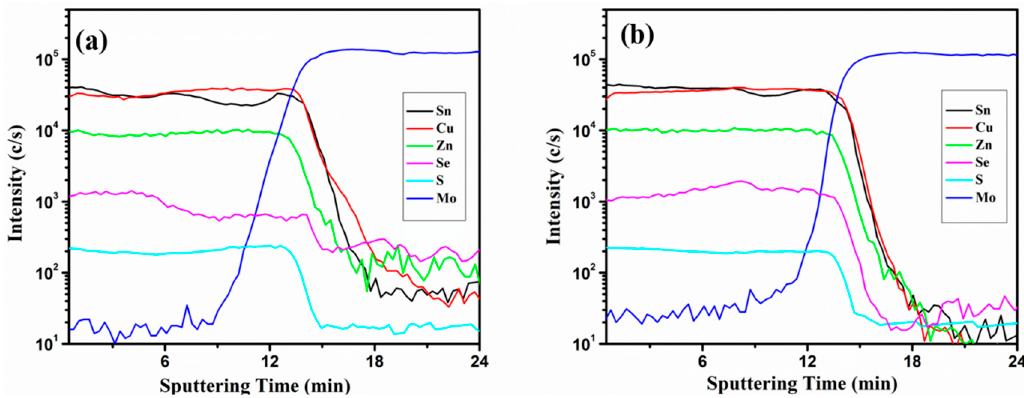
Figure 4. Secondary ion mass spectroscopy (SIMS) profiles of CZTSSe films prepared by ( a ) one-step and ( b ) three-step selenization process.